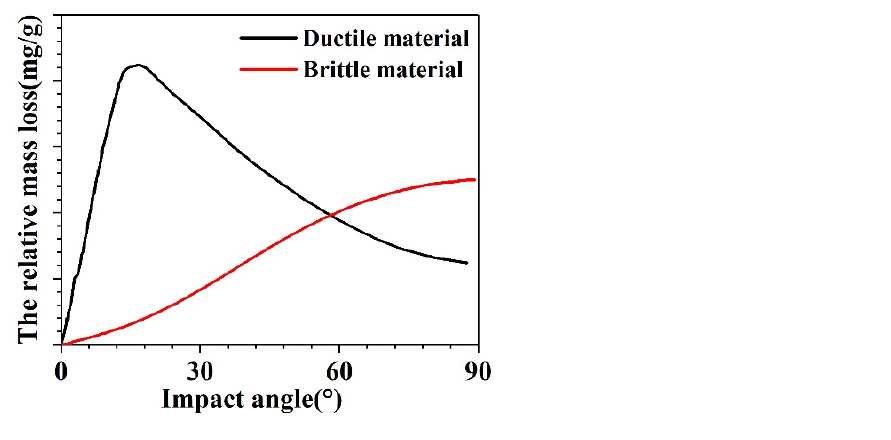
Figure 6. Relative mass loss of ductile and brittle materials with an increase in impact angle [28].